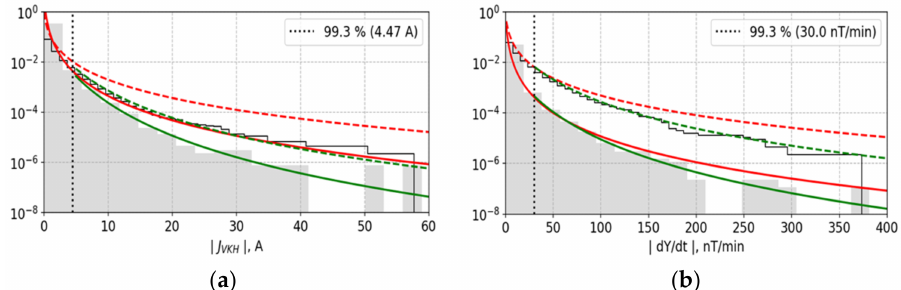
Figure 3. Statistics of the distribution of the GIC magnitudes | J | at VKH station ( a ) and the rate of the change of the Y -component of geomagnetic variations recorded at IVA station ( b ) for 2015 ( ∆ t = 1 min). Red solid and dashed lines correspond to PDF and SF of the log-normal distribution, green solid and dashed lines describe the tail of the distribution and the PDF and SF of the generalized Pareto distribution; the black solid line corresponds to ESF.